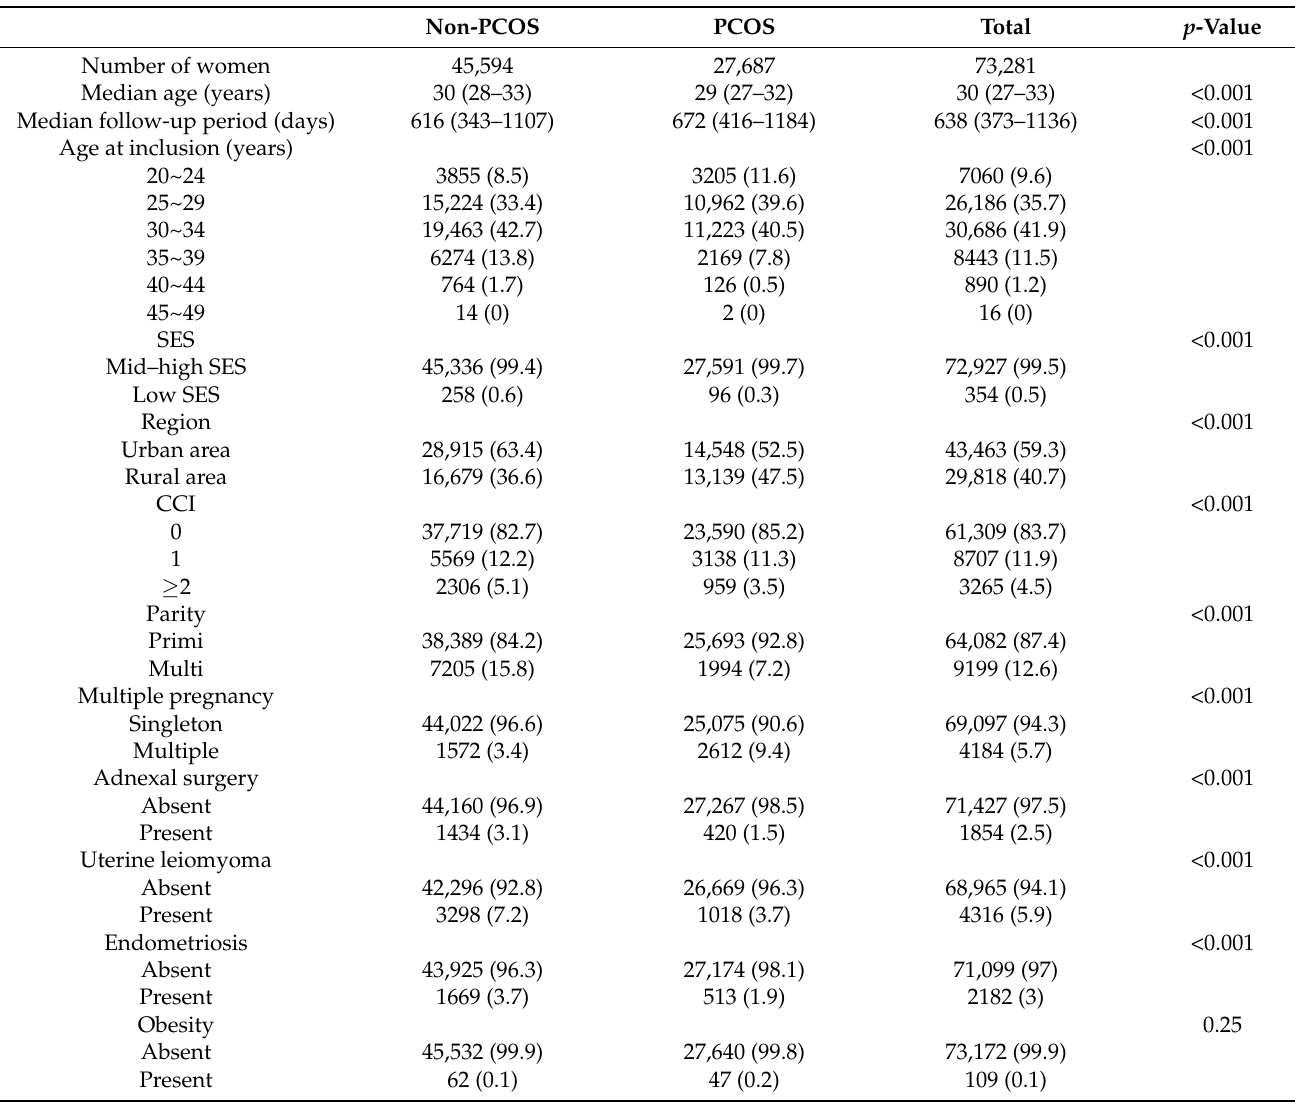
Table 1. From the National Health Insurance database, 2012–2020, baseline characteristics of women with/without PCOS. Non-PCOS PCOS Total p -Value